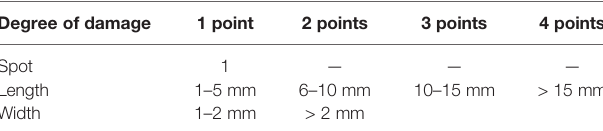
TABLE 1 | Gastric mucosal injury